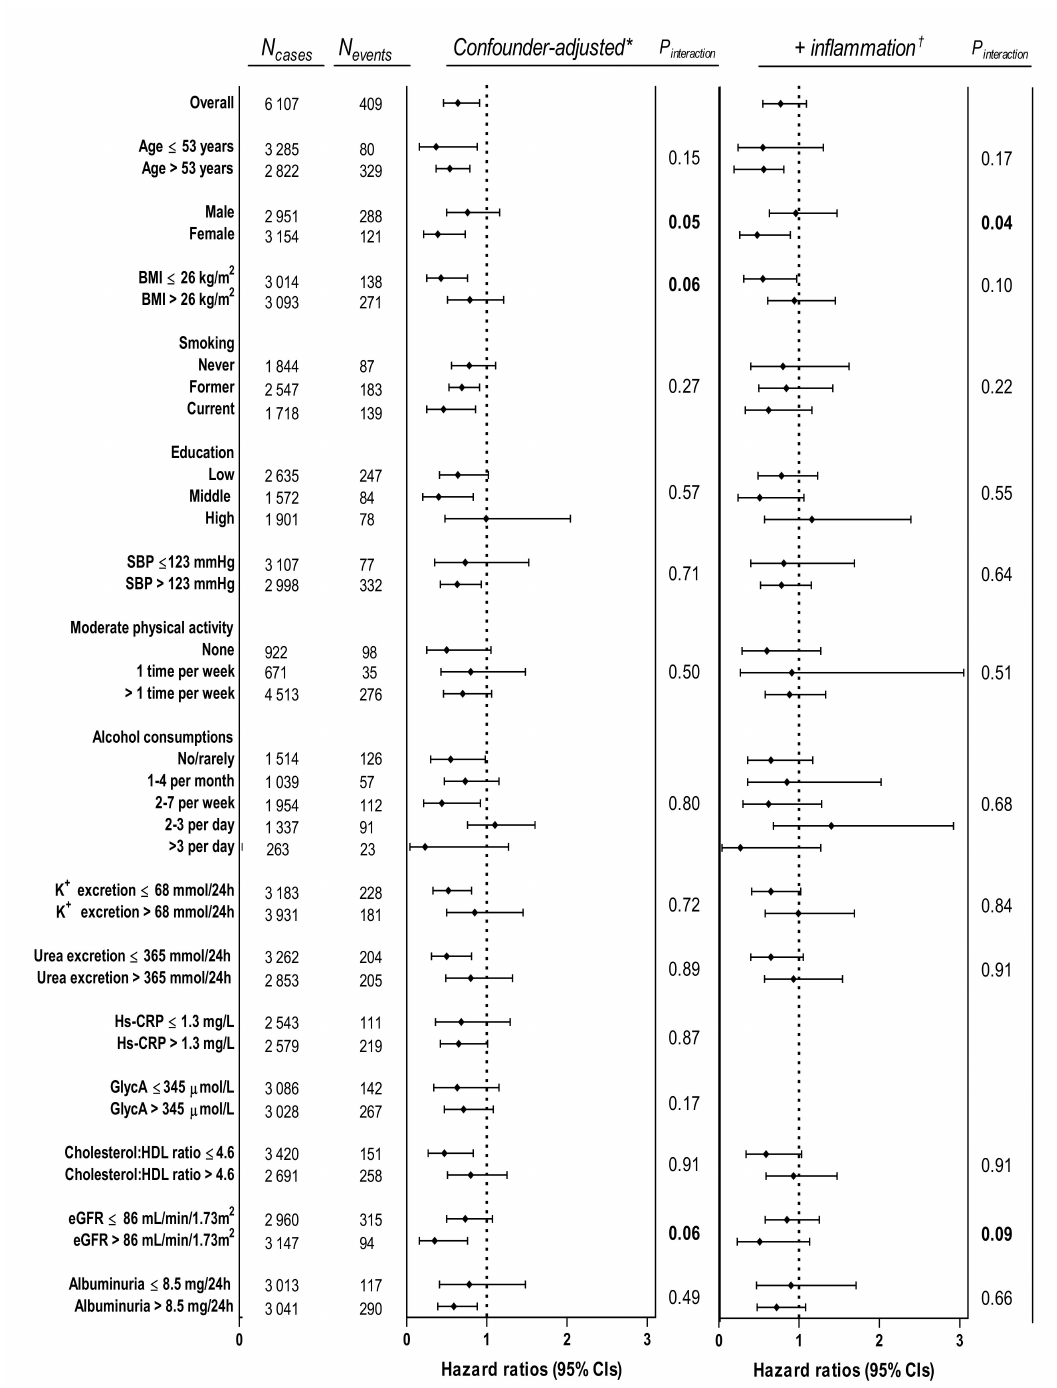
Figure2. Stratifiedanalysesforpotentiale ff ectmodificationoftheassociationbetweenplasmapyridoxal 5’-phosphate and composite cardiovascular outcome. Hazard ratios indicate relative change in risk of composite cardiovascular outcome per increment of log transformed plasma PLP. * Adjusted for age, sex, smoking, and alcohol consumption. For strata according to one of these variables, adjustments were made for the remaining three covariates. † Additionally adjusted for hs-CRP and GlycA. Abbreviations: hs-CRP, high-sensitivity C-reactive protein; PLP, pyridoxal 5’-phosphate; BMI, body mass index; SBP, systolic blood pressure; HDL, high-density lipoprotein; eGFR, estimated glomerular filtration rate; CI, confidence